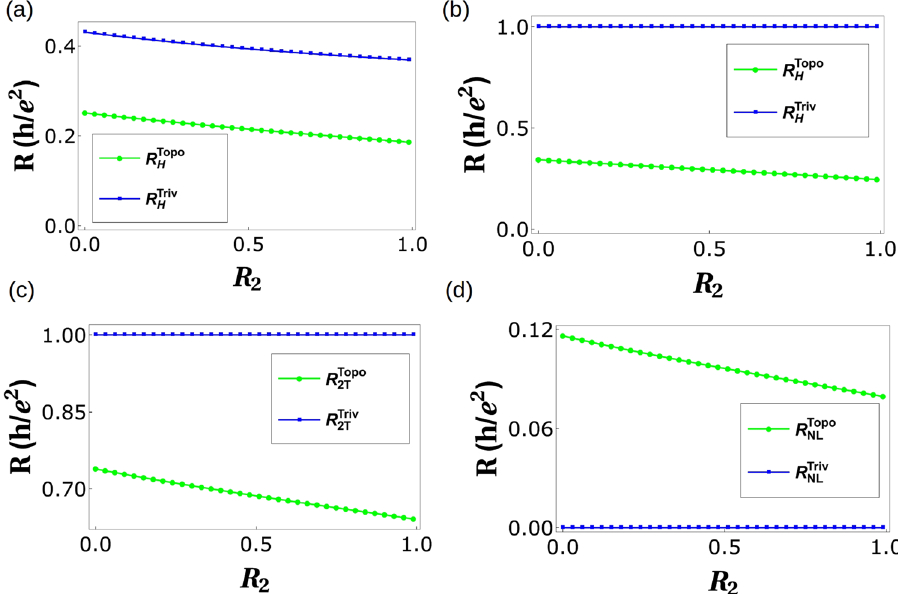
Figure 3. R NL , R 2 T and R H vs. Disorder. ( a ) Hall resistance vs. Disorder R 2 with R 4 = 0.5 and spin-flip probability f = 0.3 and f 0 = 0.3, ( b ) Hall resistance vs. disorder R 2 with R 4 = 0.5 and spin-flip probability f = 0.5 and f 0 = 0.5. ( c ) Two-terminal resistance vs. Disorder R 2 with R 4 = 0.5 and spin-flip probability f = 0.5 and f 0 = 0.5, ( d ) Non- local resistance vs. Disorder R 2 with R 4 = 0.5 and spin-flip probability f = 0.5 and f 0 =